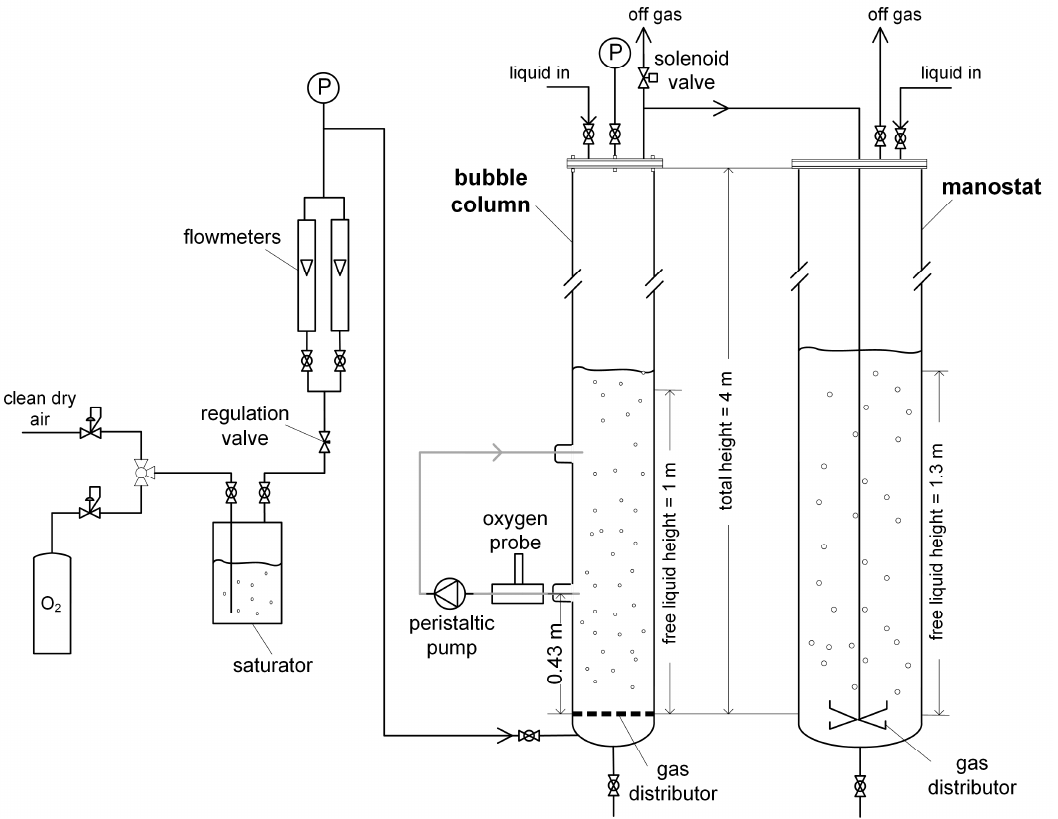
Figure 1. Experimental setup.